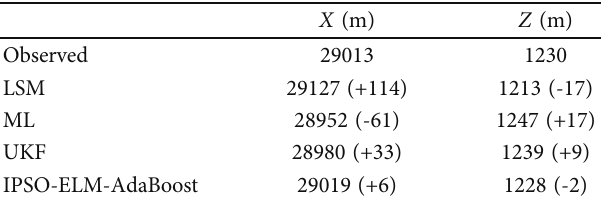
Table 6. Compared with the traditional algorithm, the pro- posed algorithm has the highest accuracy. The drop point error of IPSO-ELM-AdaBoost is 6 m, and the sideway error is 2 m. In terms of the drop point error, the drop point error of LSM and ML is more than 50 meters, which can no longer meet the need of actual engineering. From the perspective of side deviation error, UKF and IPSO-ELM-AdaBoost have good performance, and their side deviation error is less than 10 m.